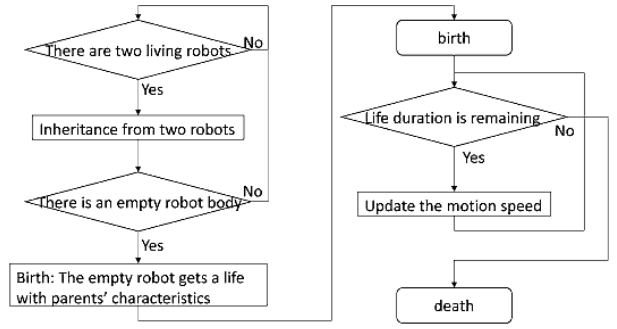
Figure 2: System (cid:13)ow